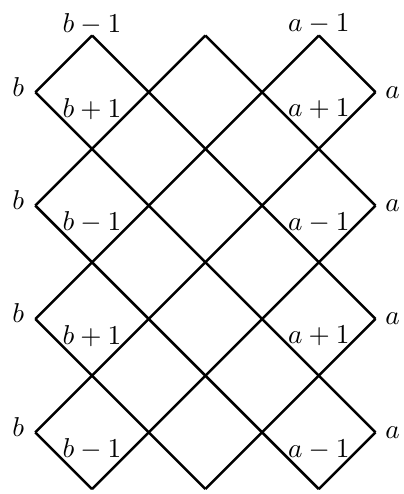
Figure 21 . Alternating boundary conditions on both sides. We will write this boundary condition b (cid:6) ; : : : ; (cid:6) a and refer to it as \correlated" boundary